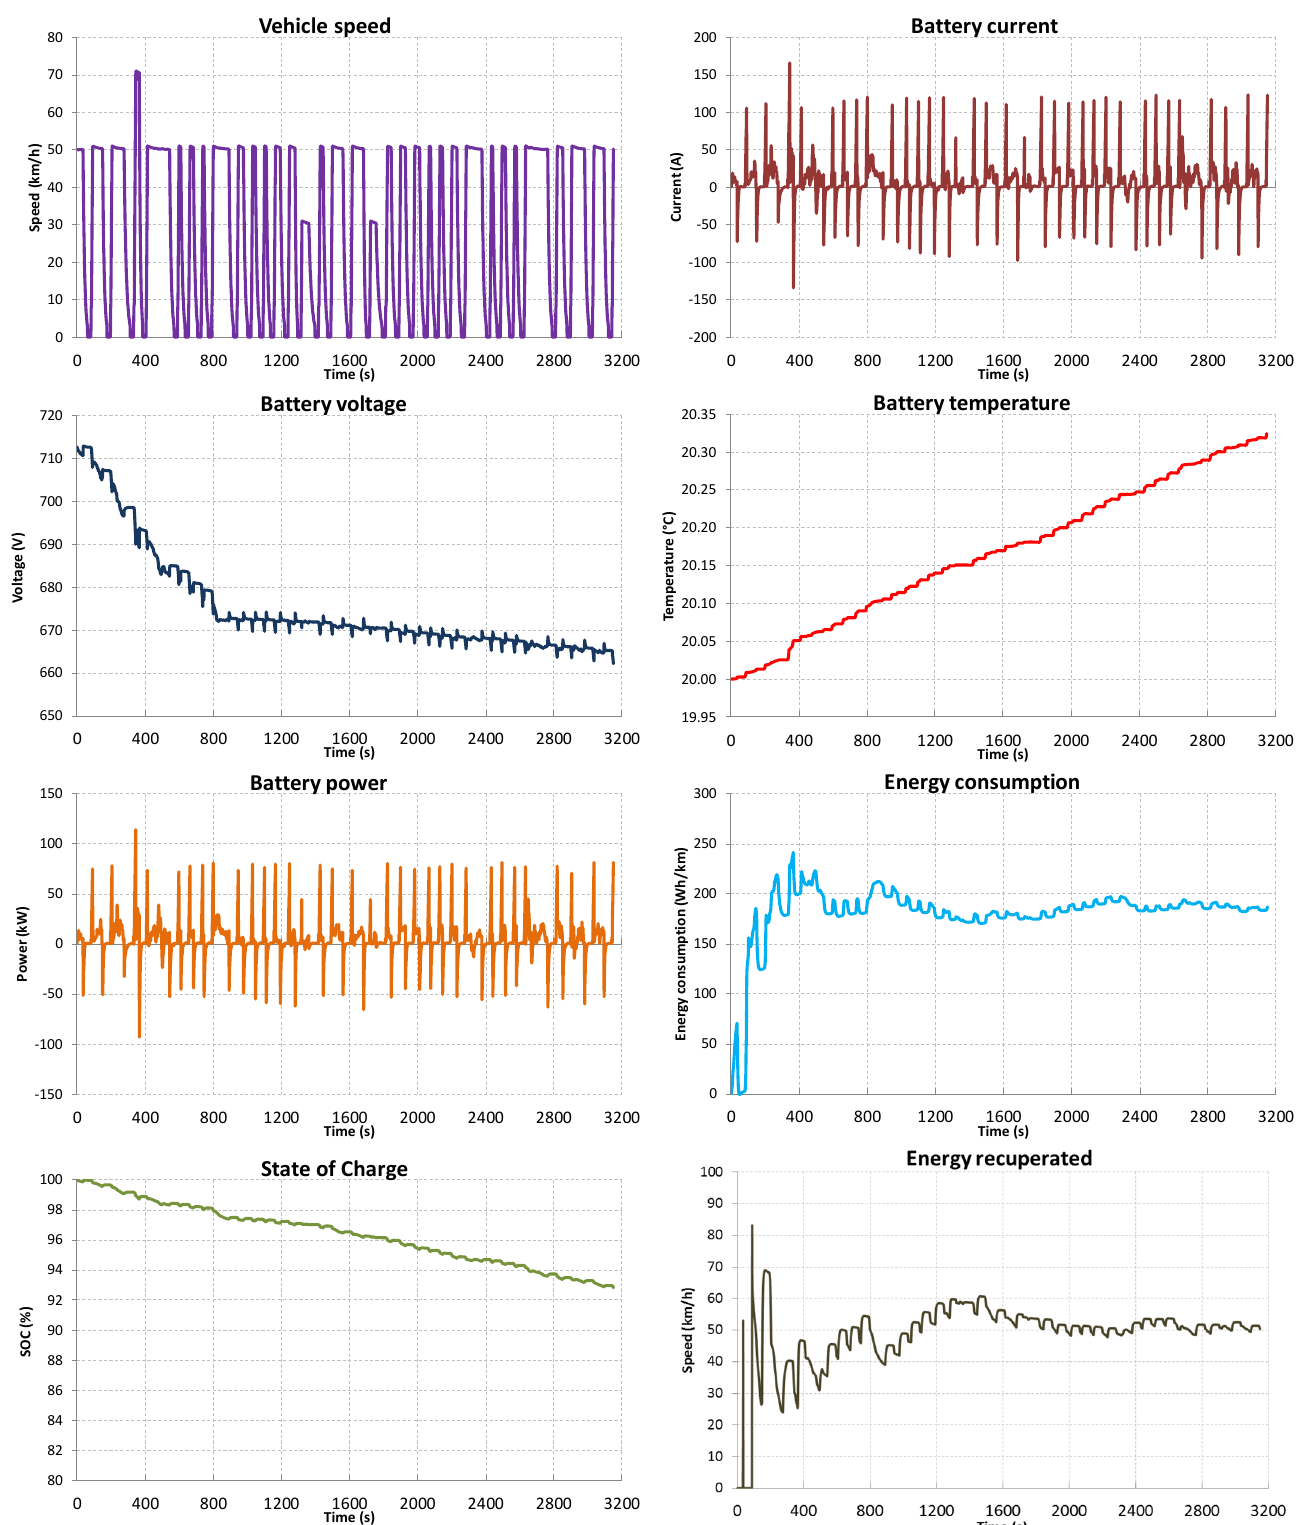
Figure 18. Results of simulation tests of the 4 × 4 drive system on the Gdynia-Flat route.